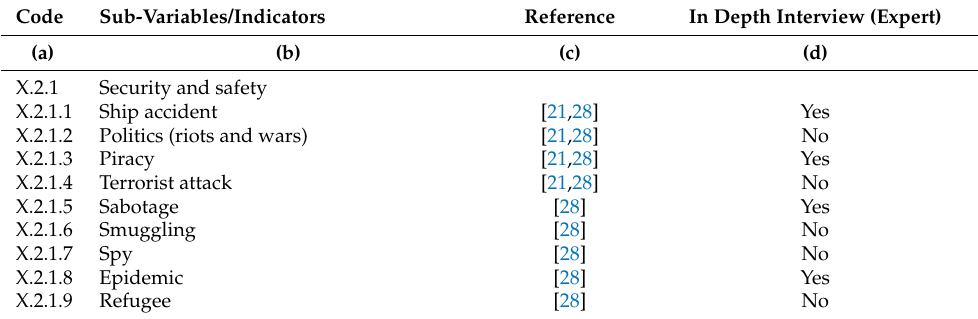
Table 3. Variables related to Risk